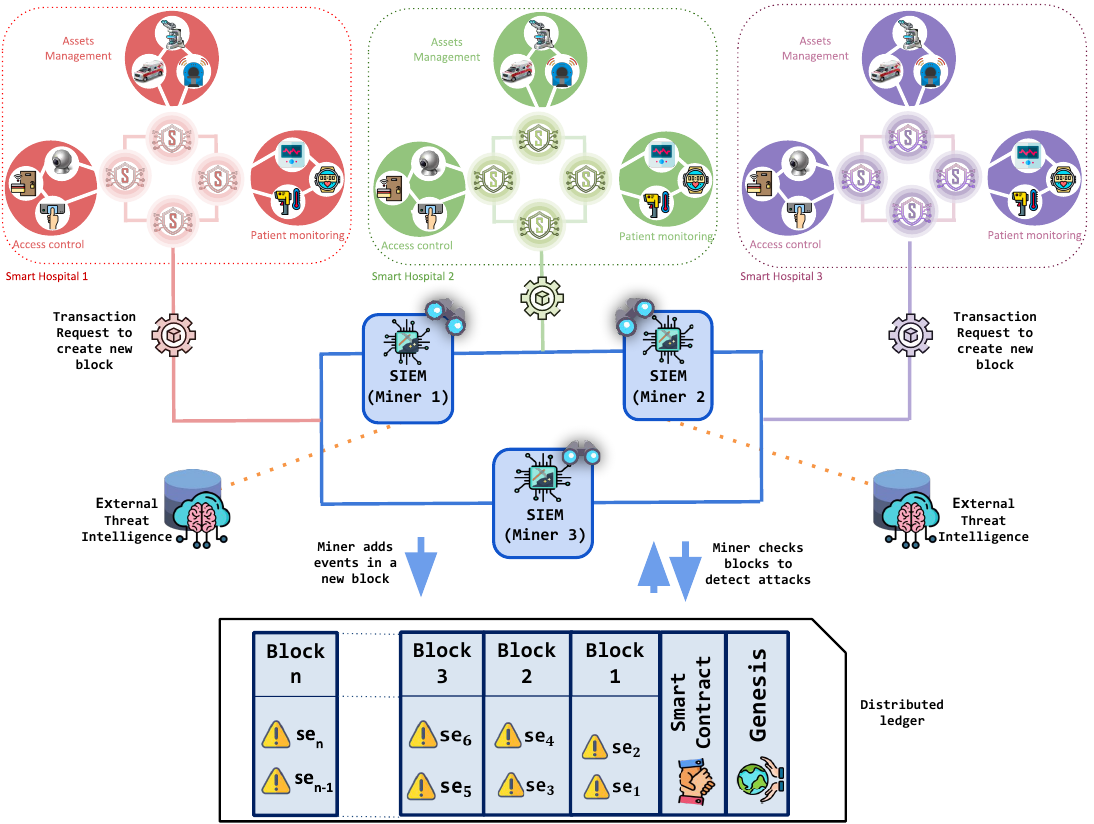
Figure 1. Architecture of a blockchain-based and distributed Security Information and Event Management (SIEM),